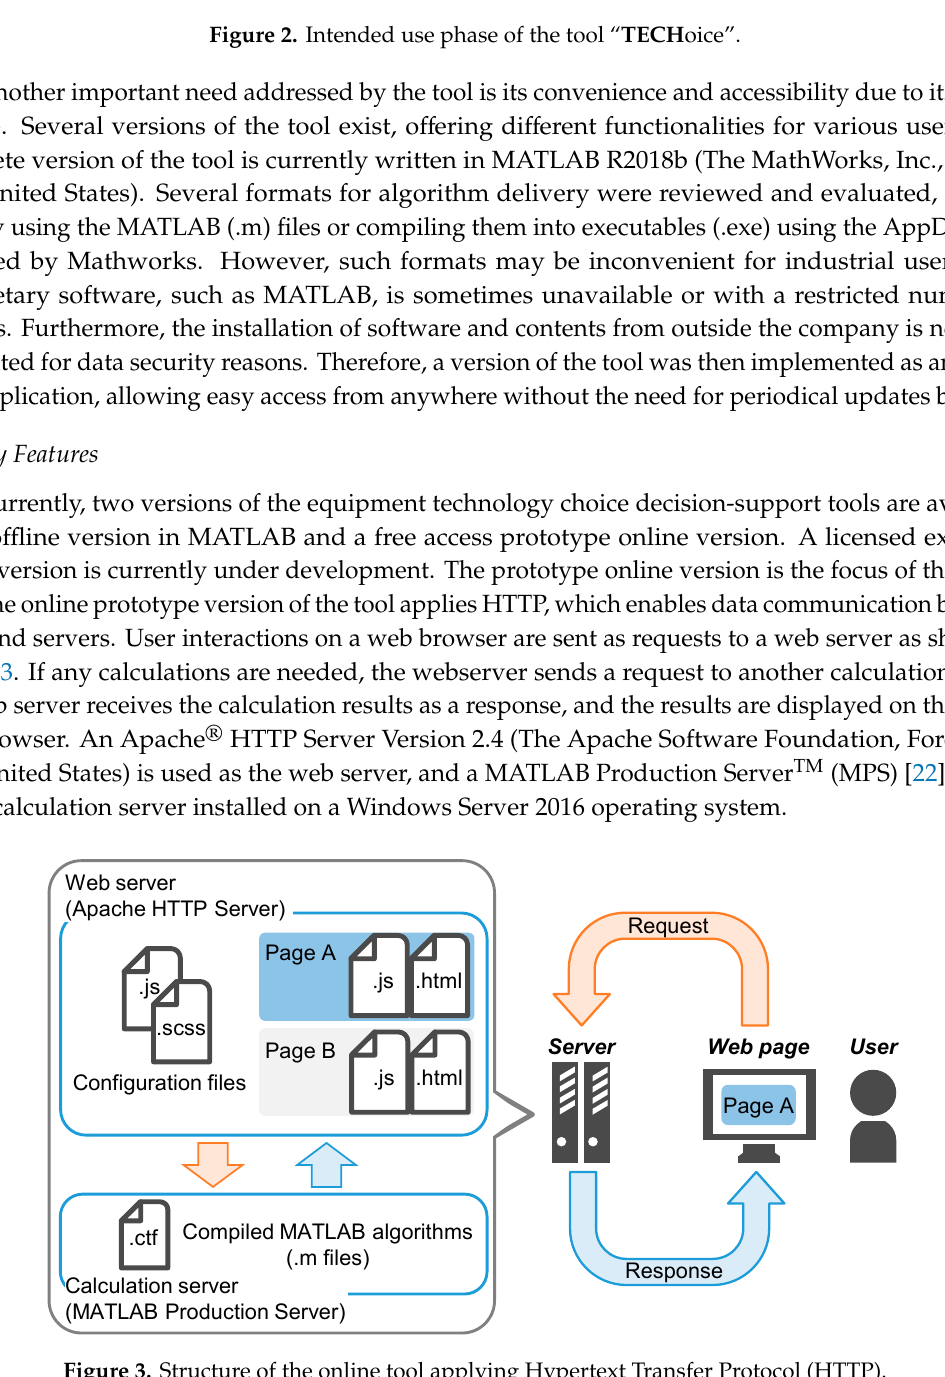
Figure 3. Structure of the online tool applying Hypertext Transfer Protocol (HTTP).